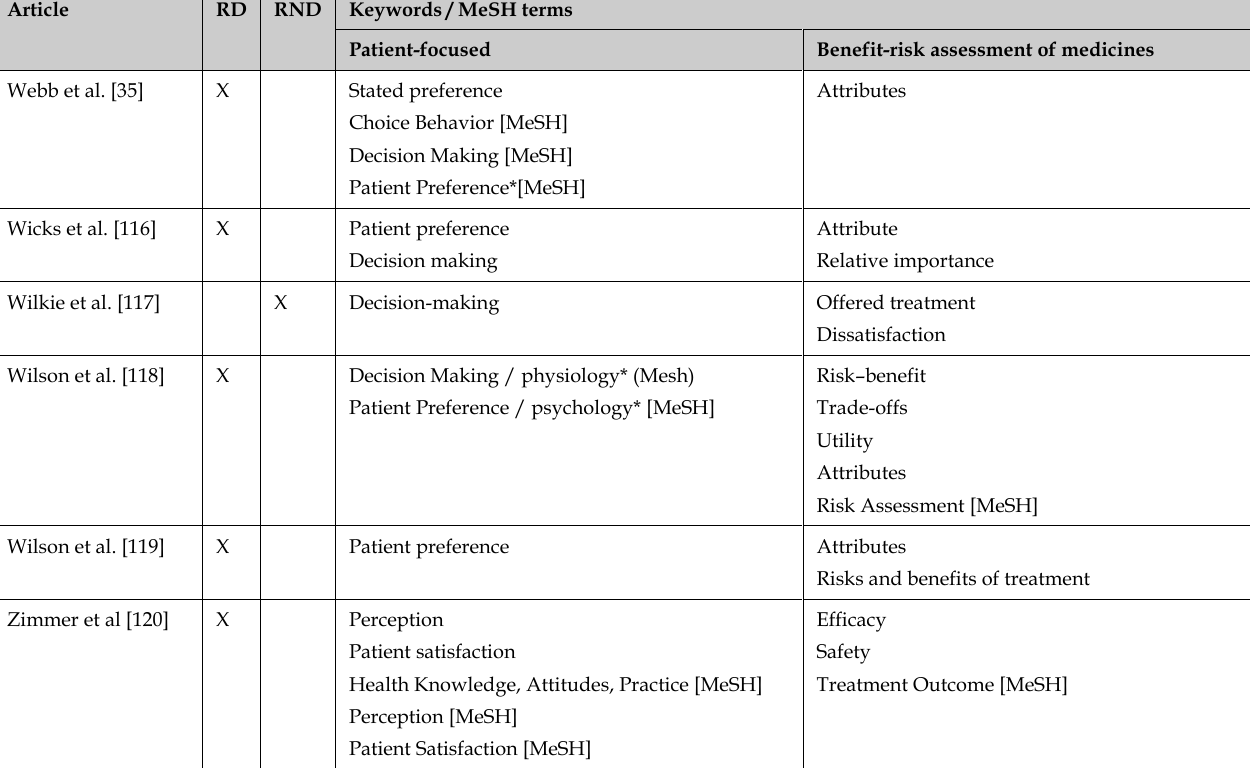
Table 3 Relevant articles on multiple sclerosis patients’ preferences regarding their medicines detected (RD) and not detected (RND) by the search strategy with corresponding keywords and MeSH terms (cont.)